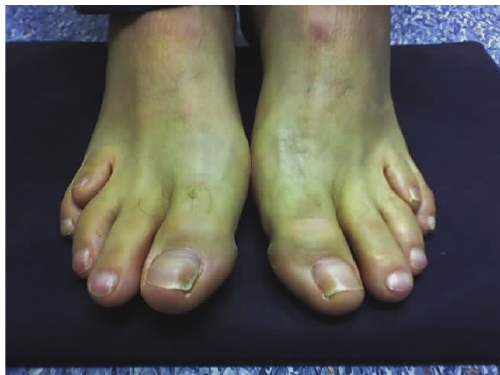
Figure 2: Shortening of AF’s fourth toe, characteristic of Refsum’s